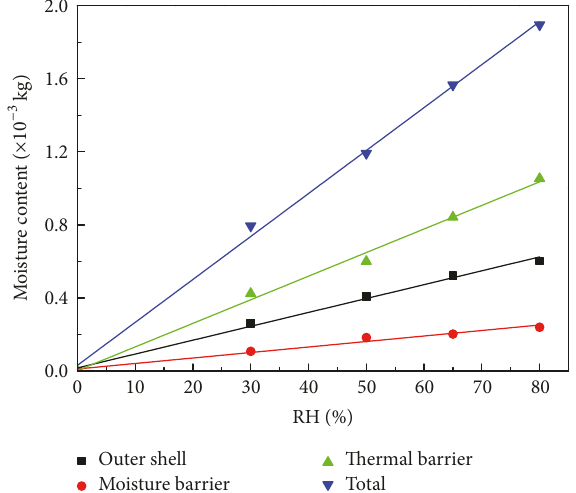
Figure7: MoistureweightineachfiberlayeragainstRH,withfitting